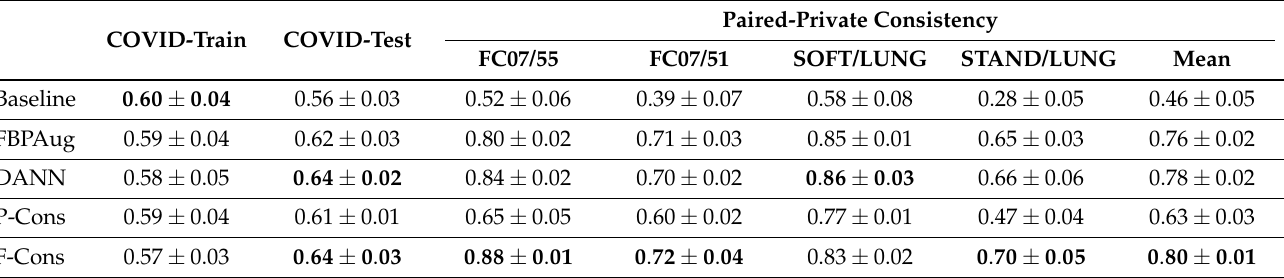
Table 3. Comparison of all considered methods. The adaptation methods are trained using all training kernel pairs of the Paired-private dataset. F-/P-Cons stand for F-/P-Consistency, where F-Consistency is our proposed method. All results are Dice Scores in the format mean ± std calculated from 5-fold cross-validation. We highlight the best scores in every column in bold .